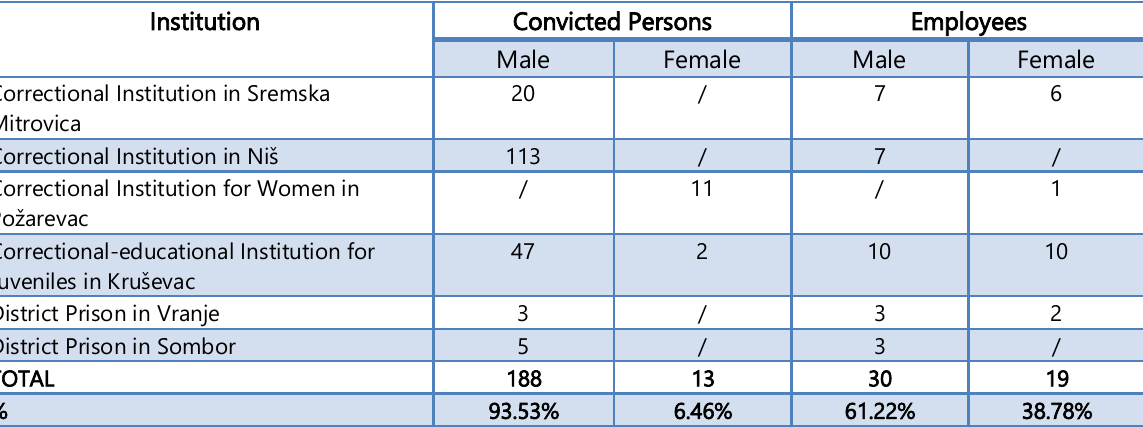
Table 5: Gender of Interviewed Persons (Source: Author‟s depiction)